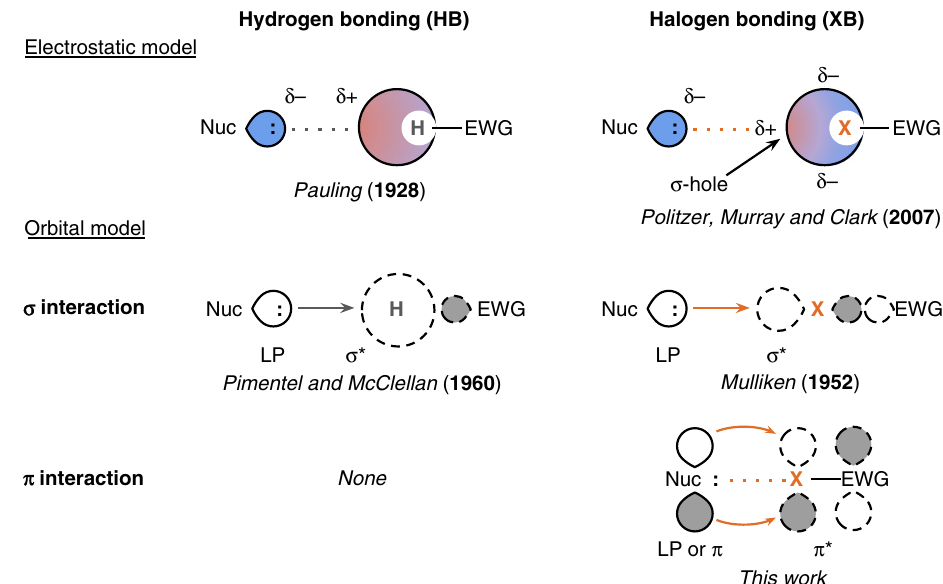
Fig. 1 Hydrogen bonding and halogen bonding models. Schematic representations of the electrostatic and covalent charge-transfer models of hydrogen bonding and halogen bonding 8,16,17,21,22,28,29 . Our study shows that covalent π bonding can also be operative in halogen